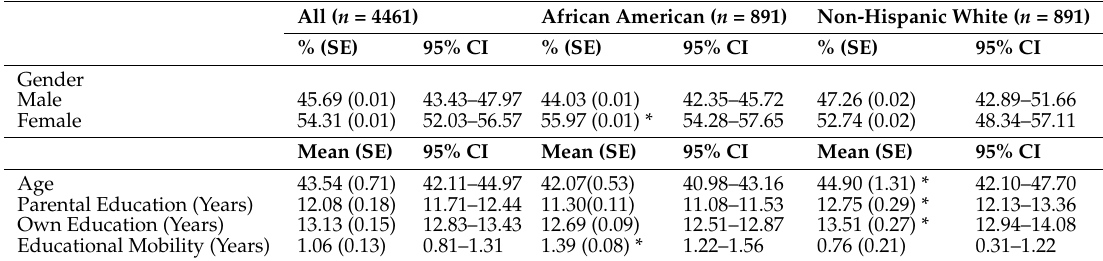
Table 1. Descriptive statistics in the pooled sample and by